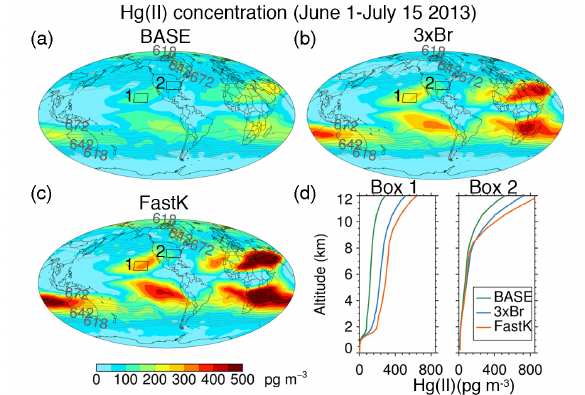
Figure 10. Average concentration of Hg(II) at 450hPa during NO- MADSS (1 June to 15 July 2013) for the (a) BASE, (b) 3 × Br, and (c) FastK simulations. The contours show the NCEP/NCAR Re- analysis 450hPa geopotential height averaged over the same period (contour interval: 6 decameter). Panel (d) indicates the mean mod- eled vertical profiles of Hg(II) concentrations for regions marked as “Box 1” and “Box 2” for the three simulations (BASE: green, 3 × Br: blue, FastK: orange).